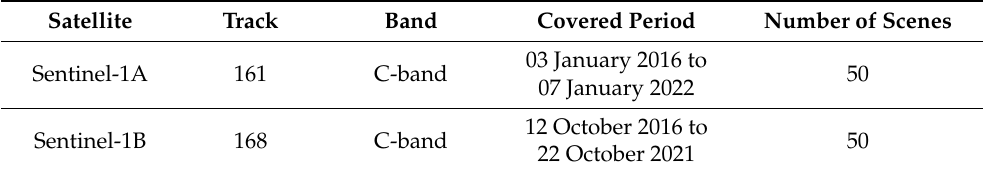
Table 1. Details of the Sentinel-1A and Sentinel-1B data used in this study.